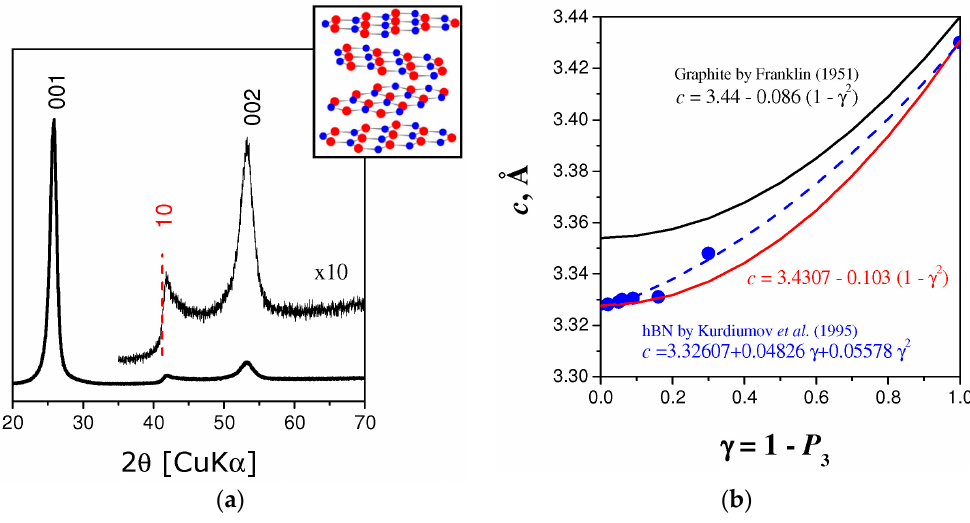
Figure 2 . Crystal structure of turbostratic BN described in the framework of the random-layer lattice model: ( a ) Typical powder diffraction pattern with approximately symmetric 00 l reflections and strongly asymmetric two-dimensional hk reflections (with displaced maximum), insert : randomly displaced and rotated BN layers forming turbostratic structure; ( b ) Interlayer distance of turbostratic BN samples with different degree of turbostratic disorder.